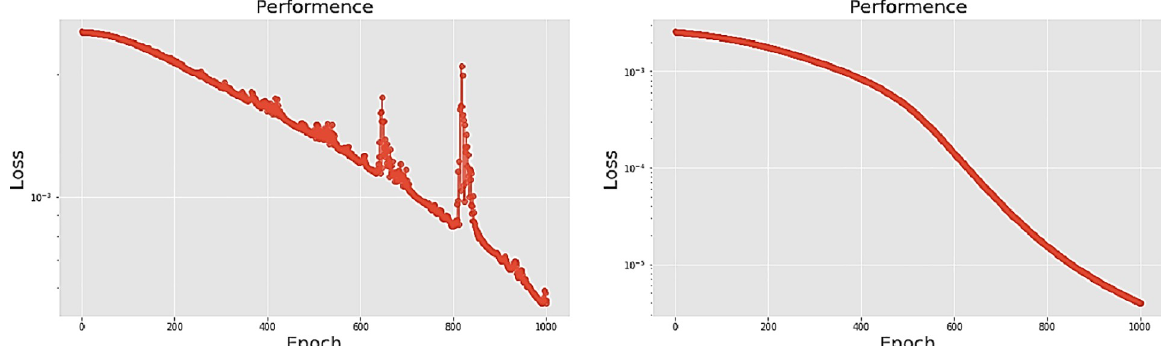
Fig 13. (a) The graph shows the performance of LPC-DNN-12-layer model; (b) The graph shows the performance of LPC-PCA-DNN-12-layer model.